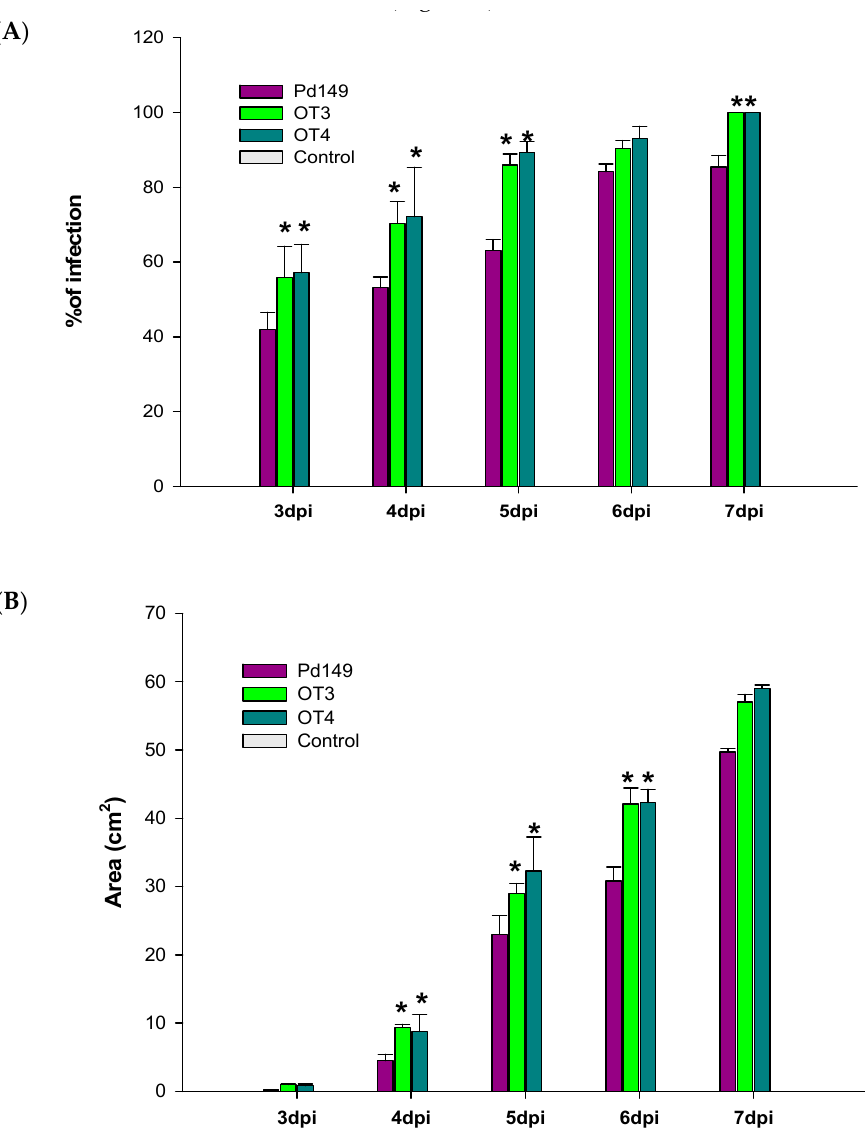
Figure 7. Evaluation of virulence as ( A ) disease incidence (%) and ( B ) disease severity (cm 2 ). Virulence evaluation of Pd149 and the overexpression transformants (OT3, OT4). All are mean of three infection experiments. Control correspond to oranges mock inoculated. Error bars represent standard deviation. * Significant differences between treatments using Tukey’s test ( p < 0.05) at each dpi.